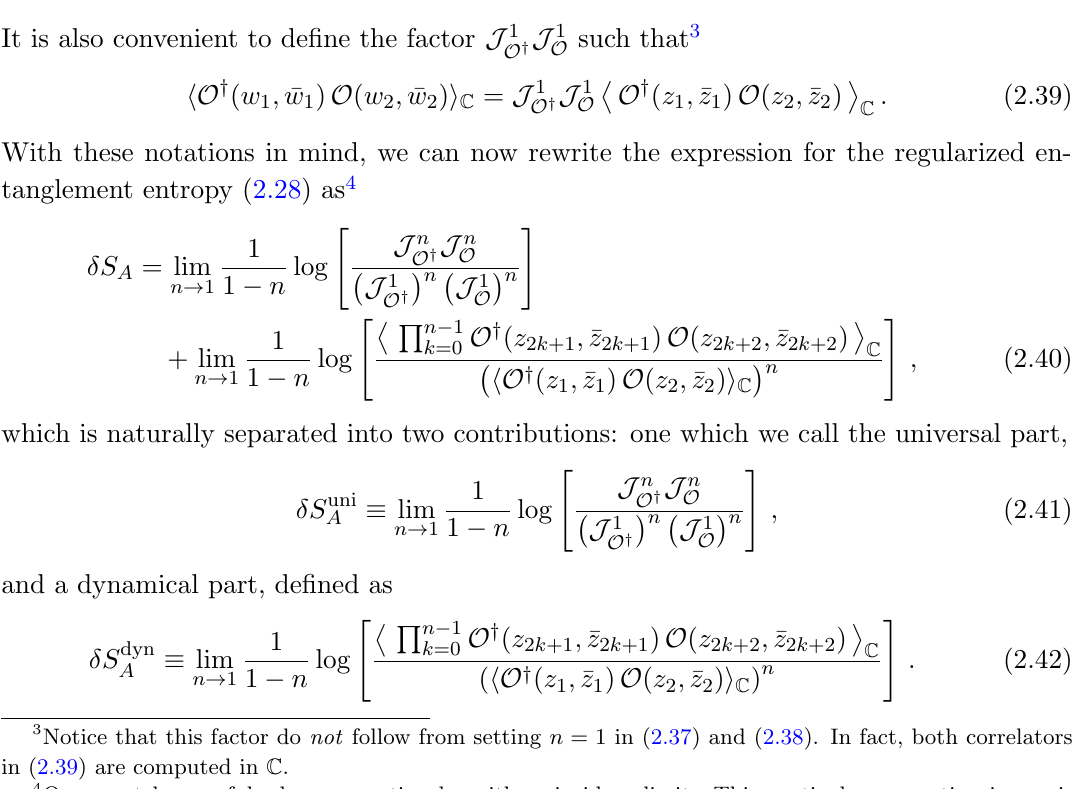
Figure 1 . Schematic representation of the uniformization map (2.30). After this transformation is implemented, each sheet of the original Riemann surface (cid:6) A maps to a wedge in the complex plane n C with 2 (cid:25) ( k (cid:0) 1) =n (cid:20) (cid:18) (cid:20) 2 (cid:25)k=n . The insertion points are mapped according to (2.33) and (2.34) which means that i ) only two of these points are inserted in each wedge and ii ) points with k (cid:21) 1 di(cid:11)er only by a phase to those with k = 0. For this plot we have set n = 12 as an illustration, but for our particular calculation we are interested in smaller values of n , speci(cid:12)cally, in the vicinity of n (cid:25)